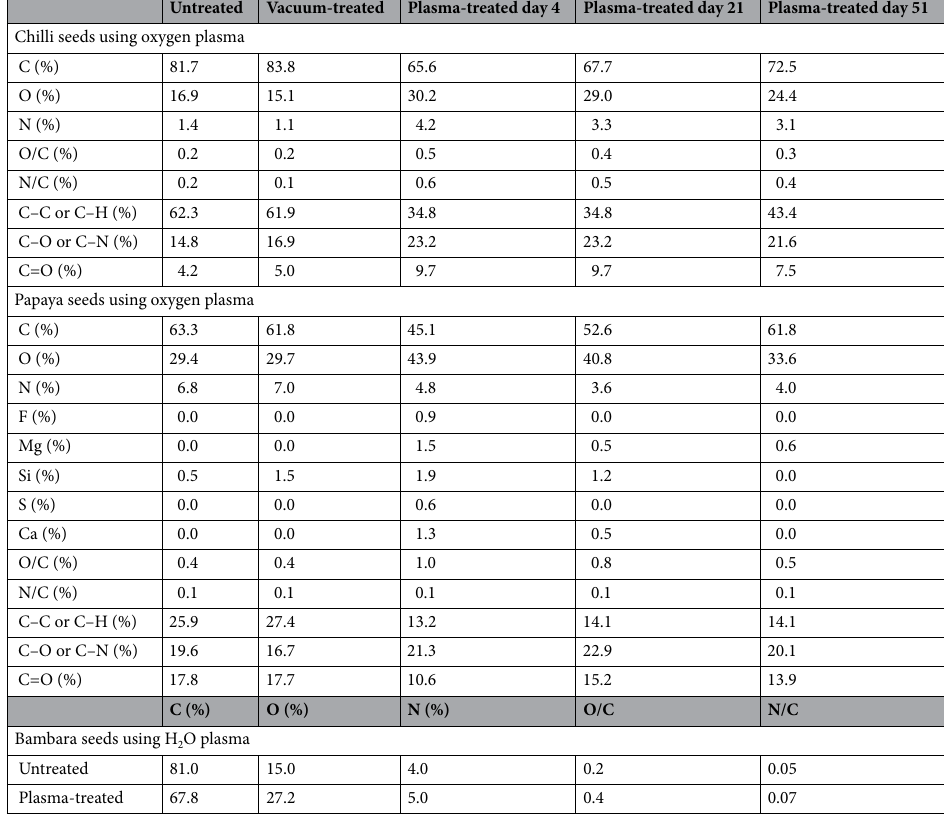
Table 1. The atomic percentage of the different elements present in Bambara, chilli and papaya seeds.